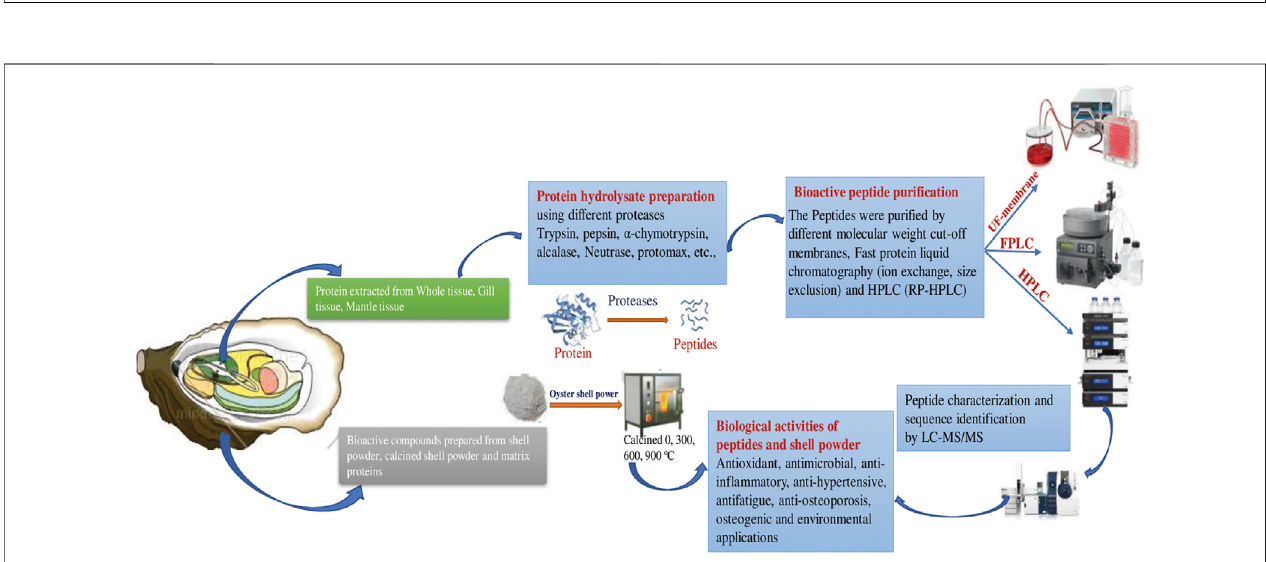
FIGURE 2 | Schematic representation of Preparation and applications of Bioactive peptides from oyster tissue and shell.